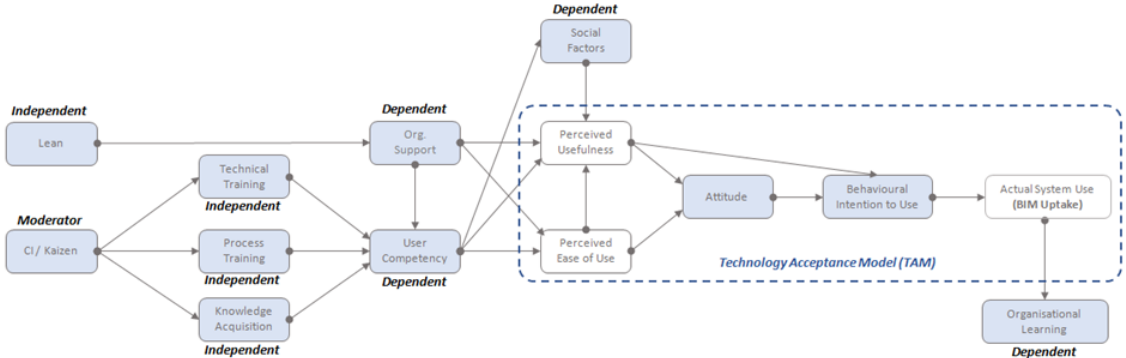
Figure 2. Proposed Organisational Upskilling Model (OUM).